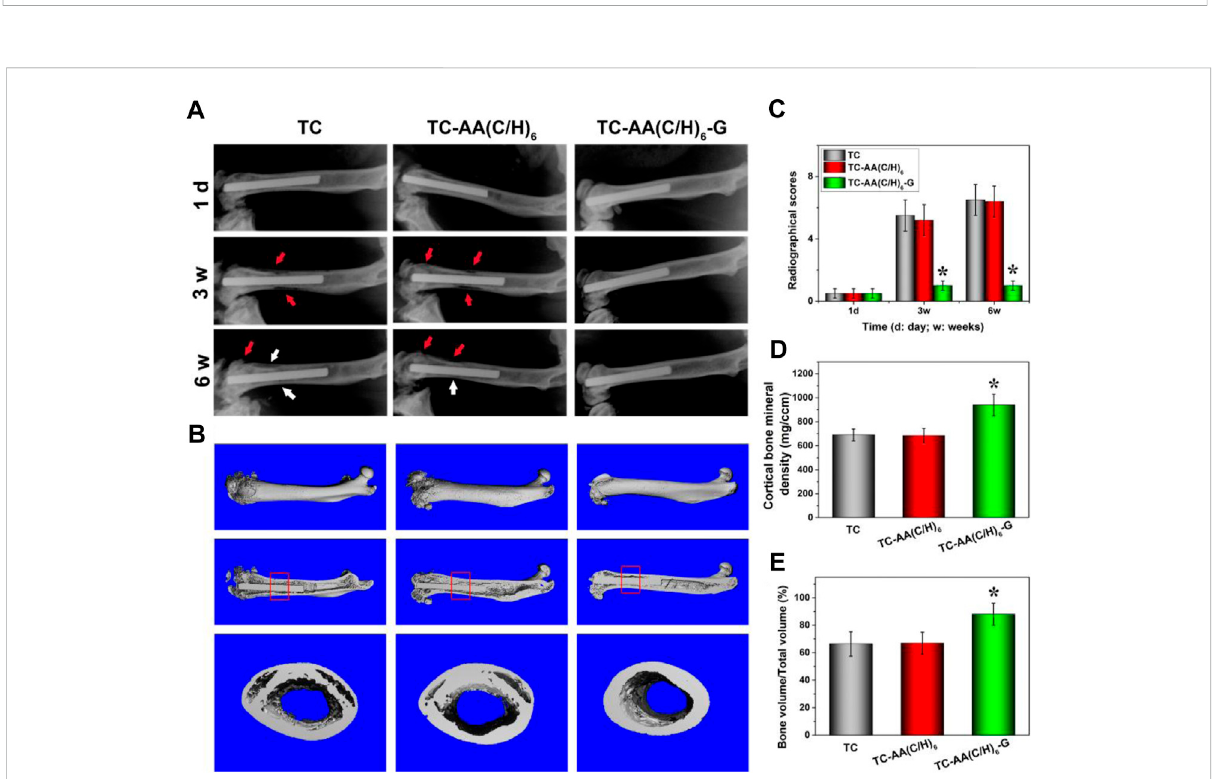
FIGURE 9 (A) X-ray photographof leftfemur in lateralview 1day, 3and 6 weeks after operation.Typical signsinclude osteolytic lesions (black arrowhead) and periosteal new bone formation (white arrowhead); (B) 3D images of overall, longitudinal and transverse sections; (C) Quantitative analysis of the X-ray images; (D) the cortical one mineral density (BMD) of ROI; (E) bone volume/total volume (BV/TV) of ROI. * p < 0.05 compared with TC-AA(C/